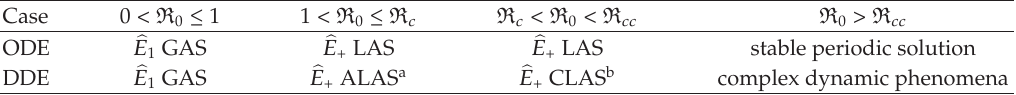
Table 1: Compare DDE (cid:2) 4.1 (cid:3) with ODE (cid:2) 4.12 (cid:3) .